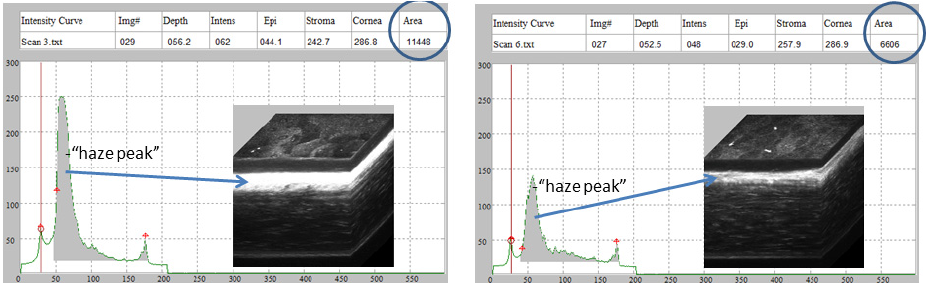
Figure 4. Rabbit CMTF haze assessment. Representative in vivo confocal microscopy through focusing (CMTF) scans and 3D reconstructions from rabbits treated with vehicle ( left ) or quercetin ( right ), 21 days after LKsurgery. The arrows denote the region of the highest haze detected within the corneal stroma.